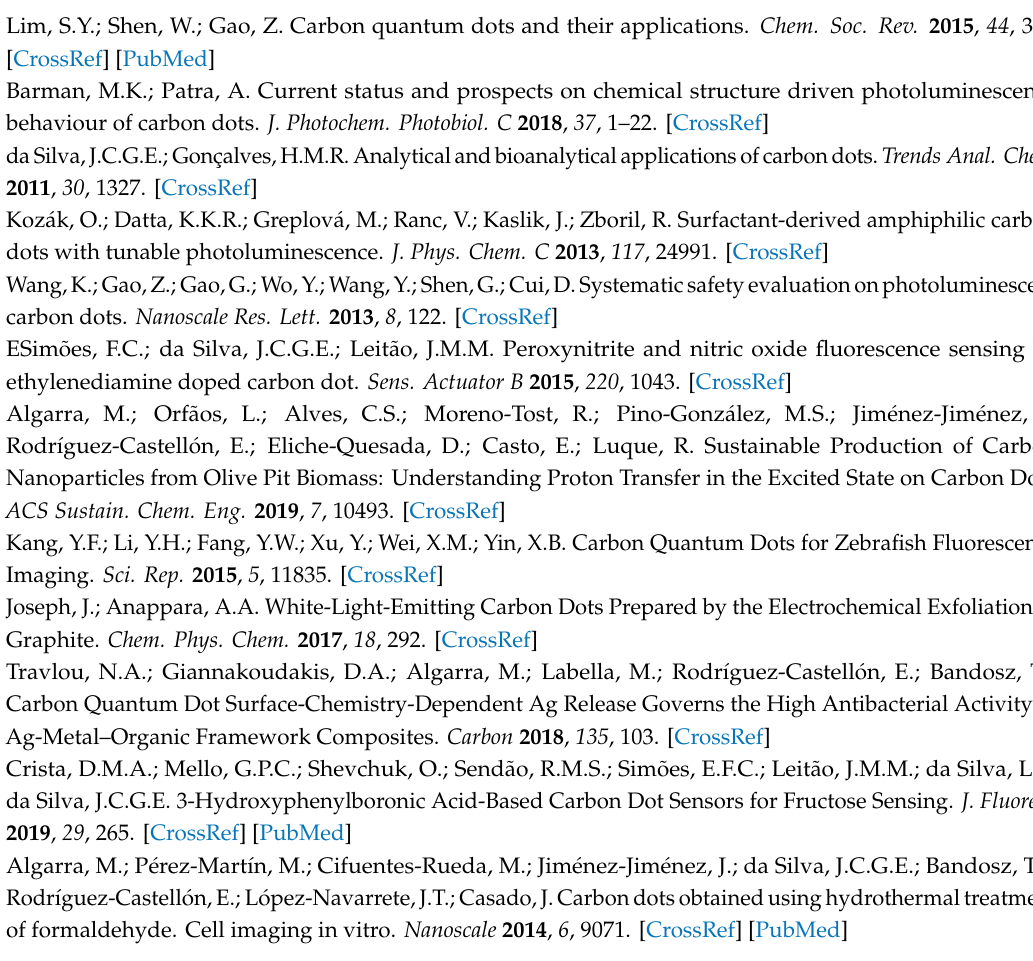
Figure S1: XPS C 1s spectra for decaf-CDs ( A ), rossio-CDs ( B ), prestige-CDs ( C ) and CA@U-CDs ( D ), Figure S2: XPS O 1s for decaf-CDs ( A ), rossio-CDs ( B ), prestige-CDs ( C ) and CA@U-CDs ( D ), Figure S3: XPS N 1s spectra for decaf-CDs ( A ), rossio-CDs ( B ), prestige-CDs ( C ) and CA@U-CDs ( D ), Figure S4: Comparative environmental profiles for the synthesis of all CDs, rescaled with respect to the QY FL of the CDs, by changing the input of citric acid to 70% ( A ) and to 130% ( B ) of the original value, Figure S5: Comparative environmental profiles for the synthesis of all CDs, rescaled with respect to the QY FL of the CDs, by changing the input of urea to 70% ( A ) and to 130% ( B ) of the original value, Figure S6: Comparative environmental profiles for the synthesis of all CDs, rescaled with respect to the QY FL of the CDs, by changing the input of electricity to 70% ( A ) and to 130% ( B ) of the original